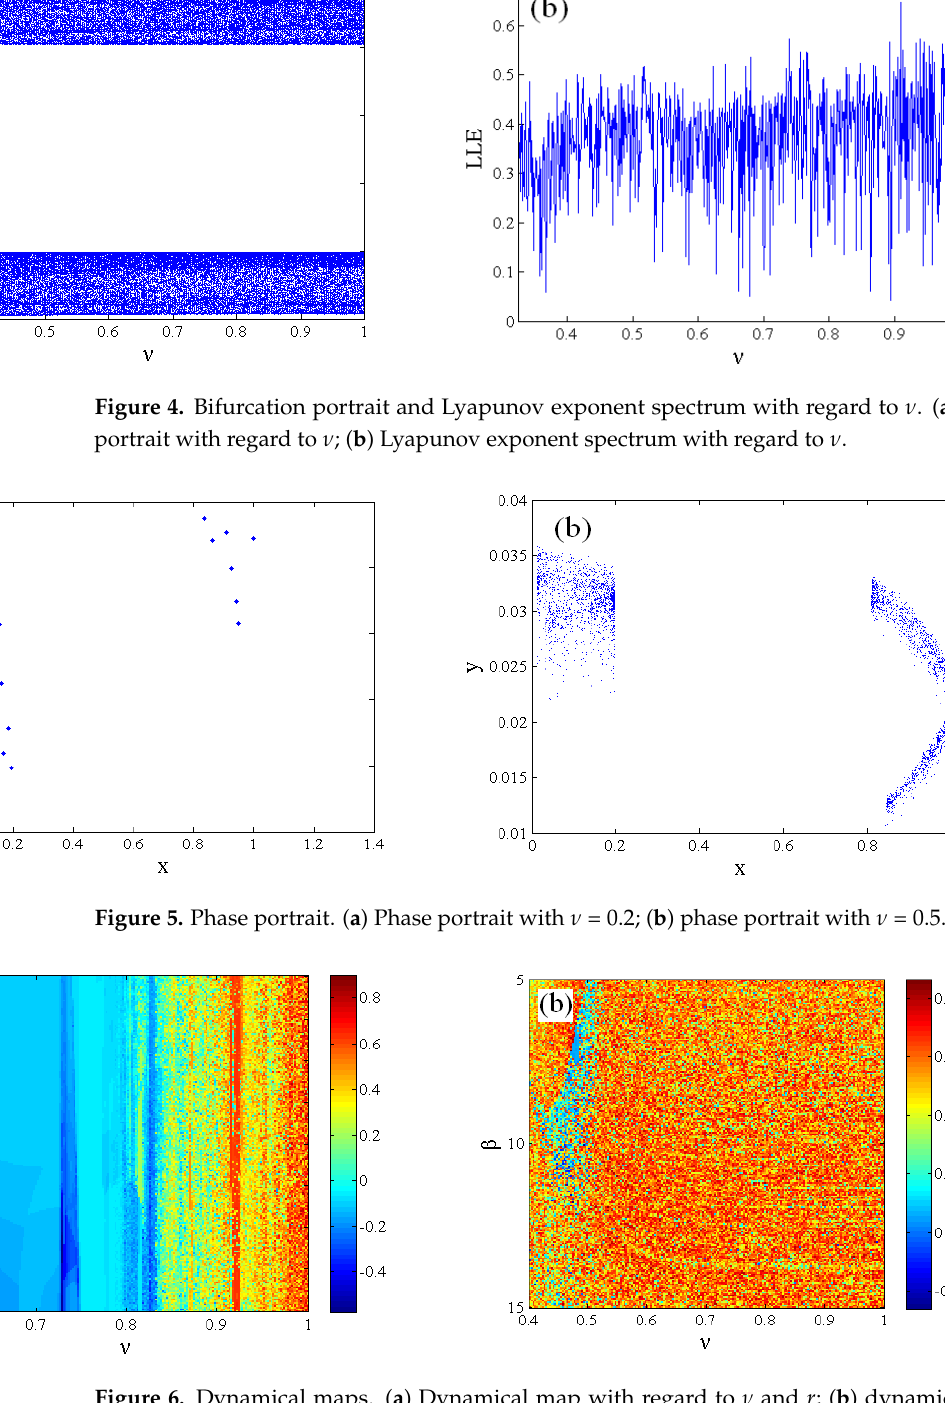
Figure 6. Dynamical maps. ( a ) Dynamical map with regard to ν and r ; ( b ) dynamical map with regard to ν and β .